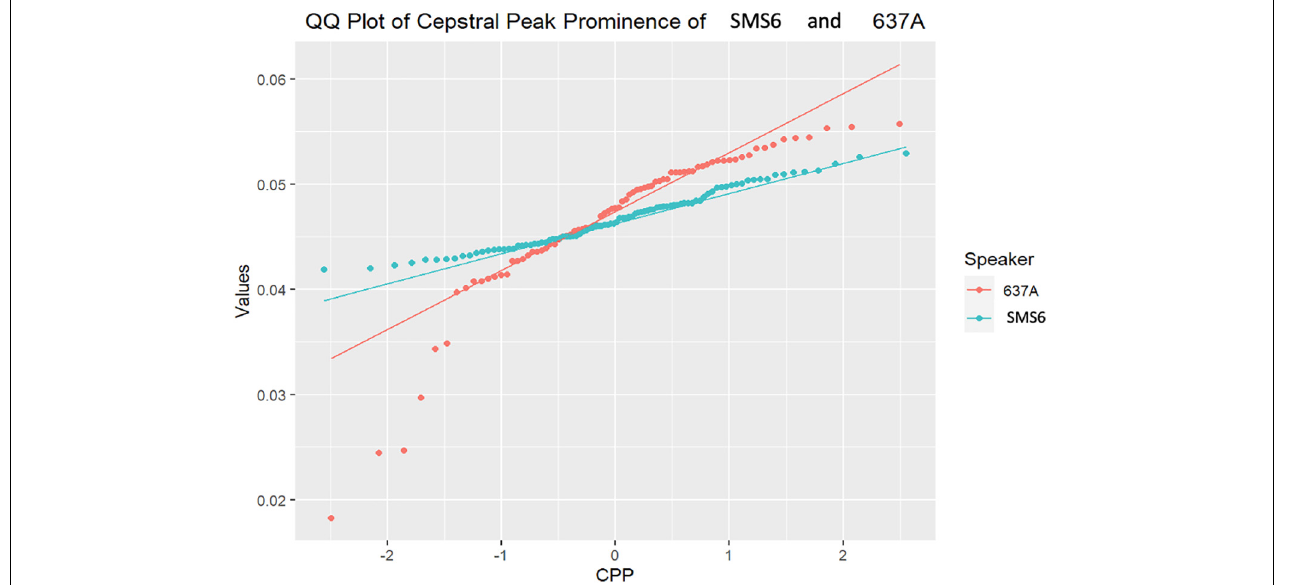
FIGURE 5 | Q–Q plot of SMS6 and 637A cepstral peak prominence (CPP) distributions.